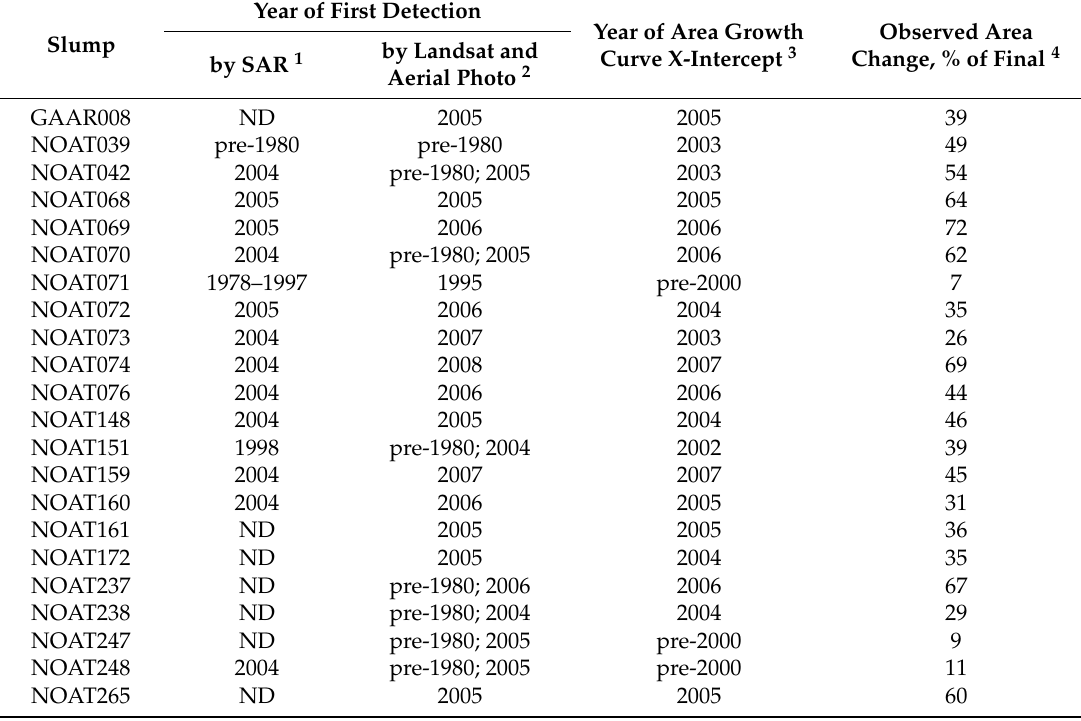
Table 3. Initiation years and previous slumping activity on the study